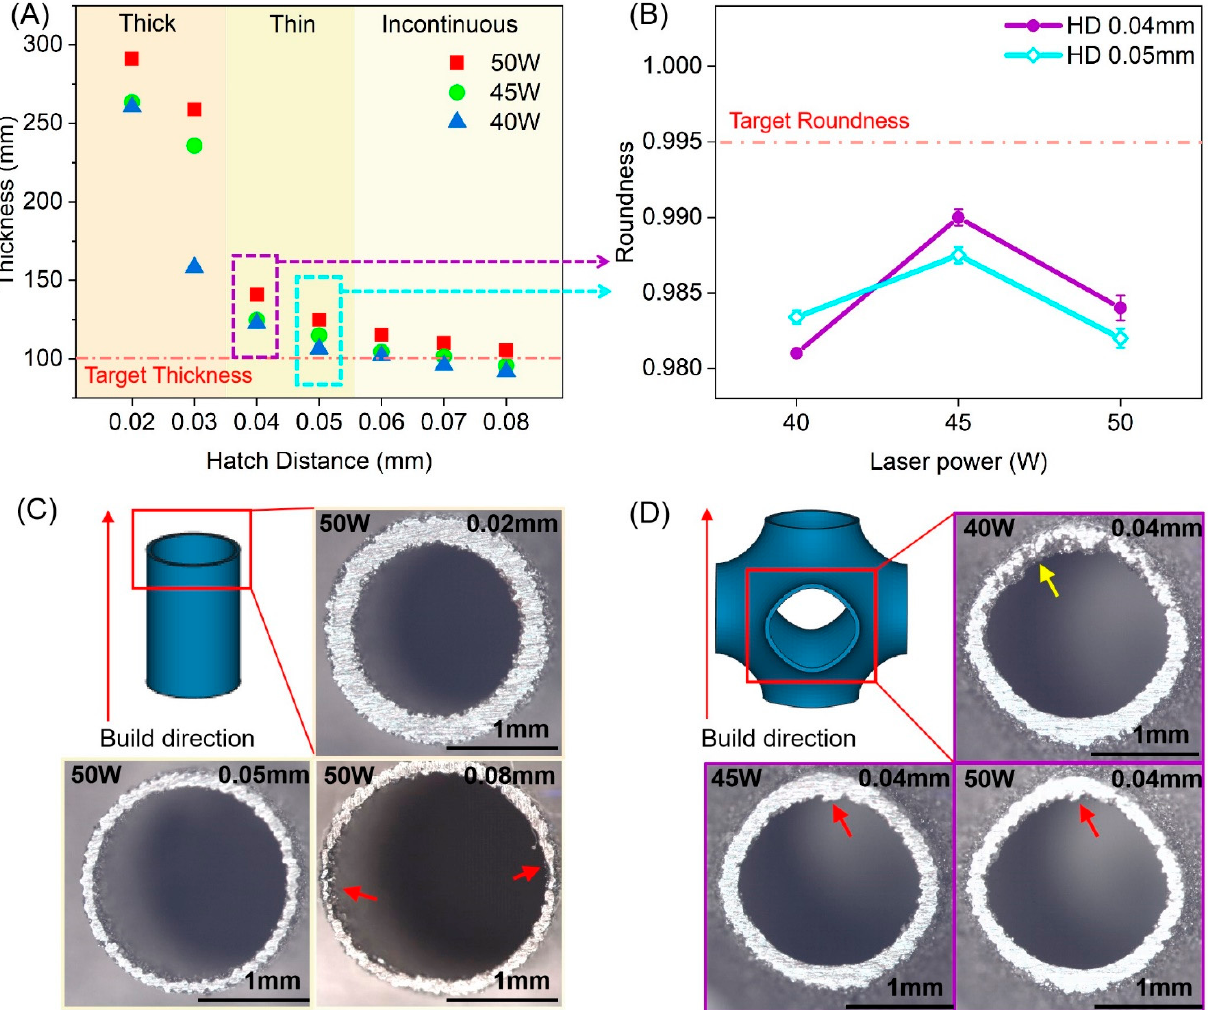
Figure 3. ( A , C ) The wall thickness and OM images of cylinders printed by 40–50 W power and 0.02–0.08 mm HD; ( B , D ) The roundness and OM images of side cross-section of P-TPMS TWS printed by 40–50 W power and 0.04/0.05 mm HD.